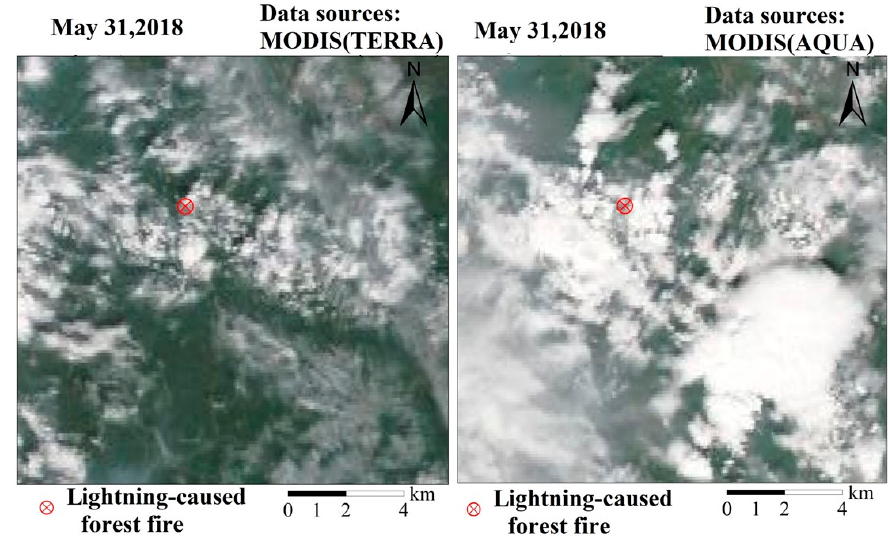
Figure 10. True color images from the time of the lightning-caused forest fires on 31 May 2018.